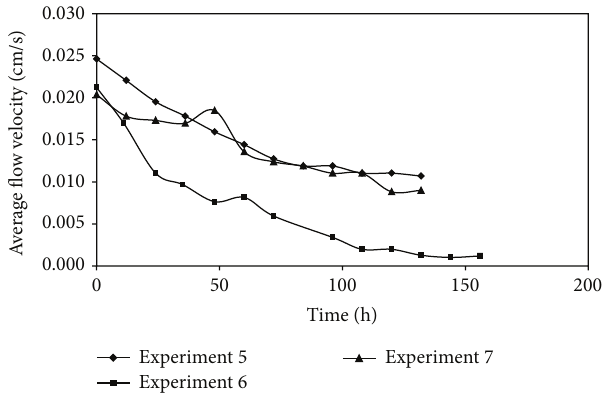
Figure 15: Relationship between the average flow velocity in the tailings column and time.